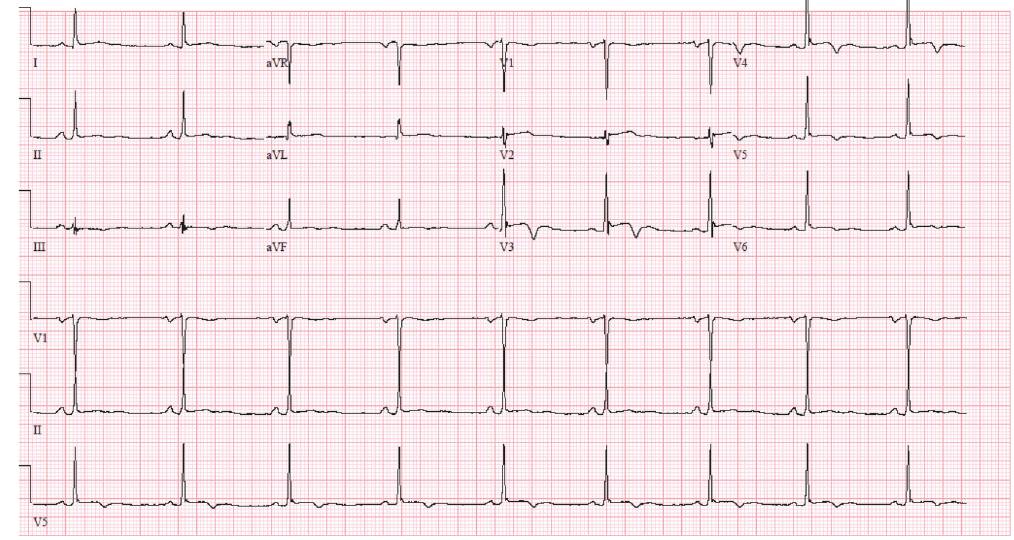
Figure 4: ECG postoperative day 1 showing ST elevation with new T wave inversions in leads